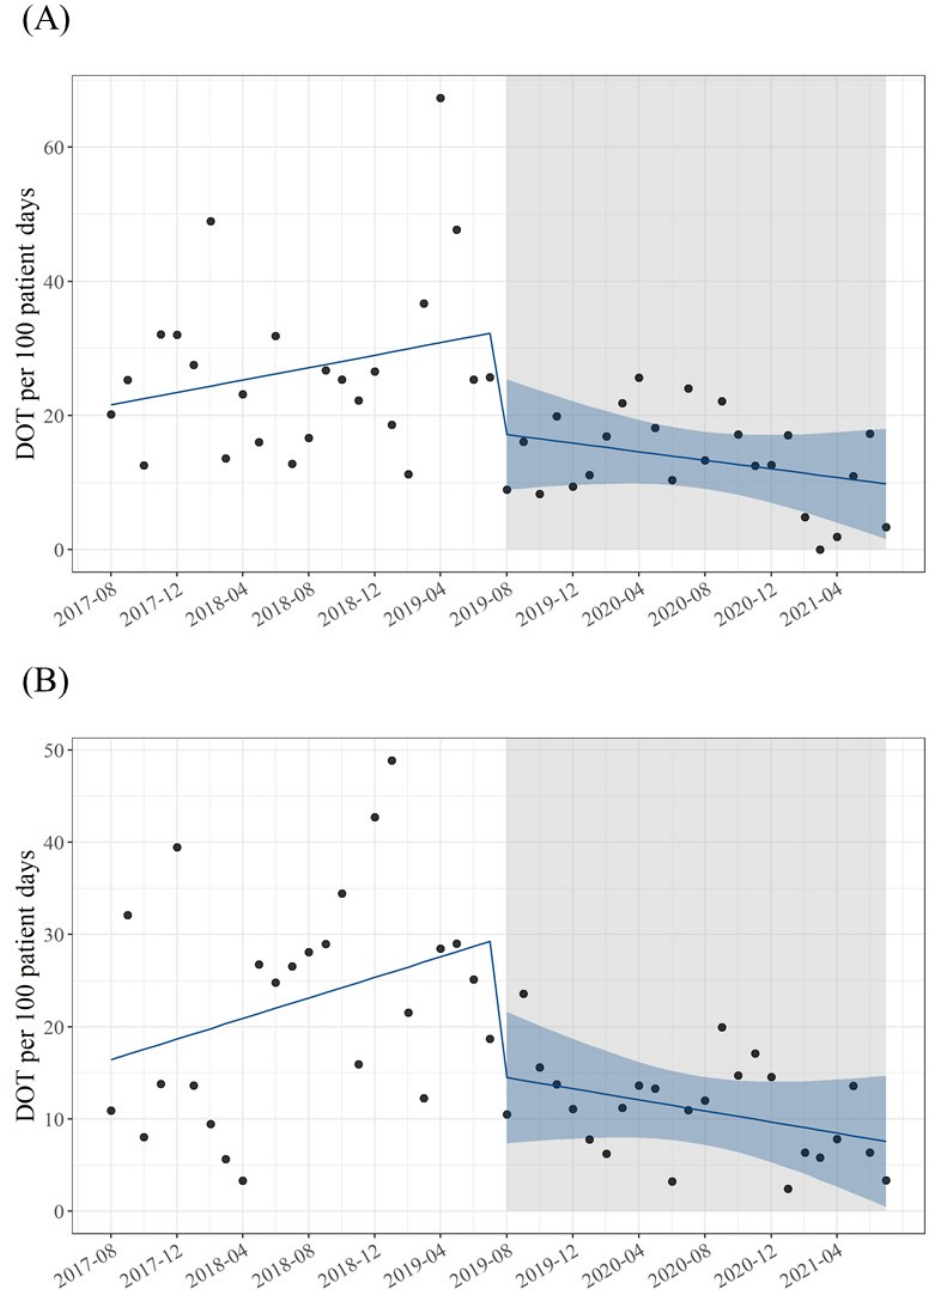
Figure 3. ITS analysis for DOT of carbapenem or tazobactam/piperacillin. ( A ), DOT of carbapenem; ( B ), DOT of tazobactam/piperacillin. The gray area indicates the start of pharmacist-driven PAF. The dots indicate the measured values for each month, and the blue line indicates the regression line. The light blue band indicates 95% confidence interval. Abbreviation: ITS, interrupted time series; PAF, prospective audit with intervention and feedback.